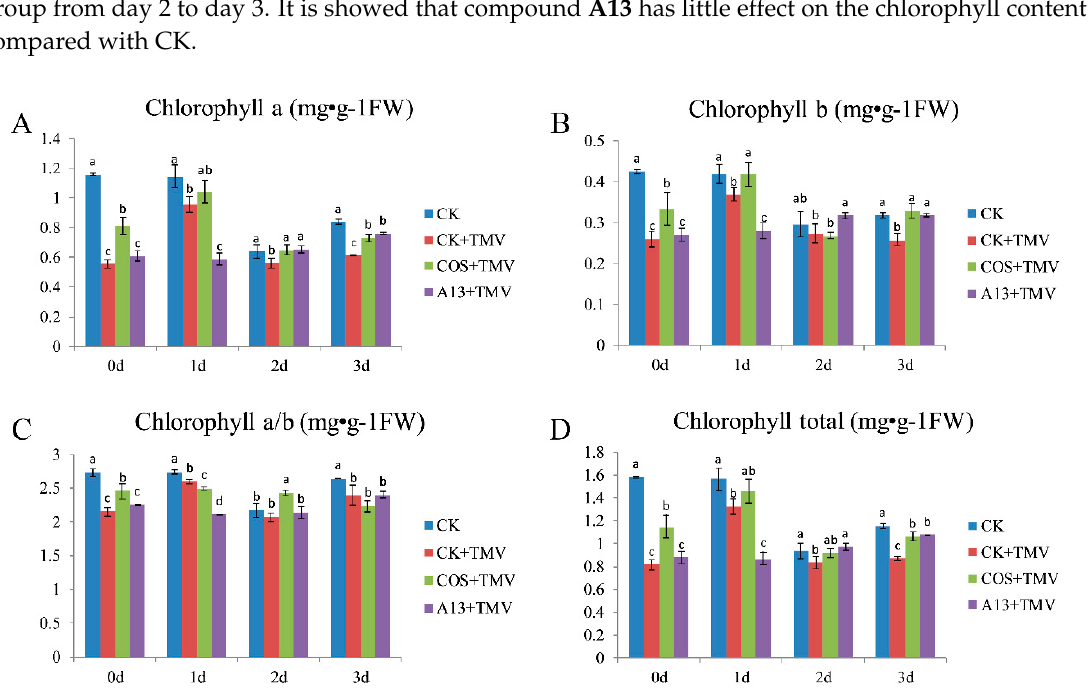
Figure 3. The effects of compound A13 on the Ca ( A ), Cb ( B ), chlorophyll a/b ( C ), and Ct ( D ) content in tobacco leaves. Bars indicate the mean of three replicates with the standard deviations. Different letters on the bars indicate statistically significant differences in average values by one-way ANOVA ( p < 0.05).